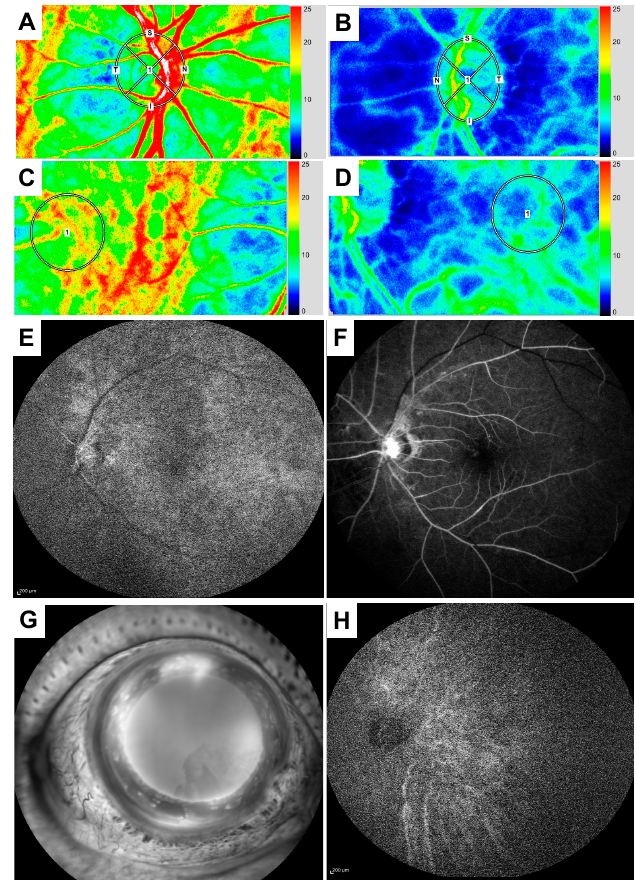
Figure 2. Laser speckle flowgraphy, fluorescein, and indocyanine green angiography findings from the baseline visit. Laser speckle flowgraphy (LSFG) findings in the optic nerve head (ONH) of the right ( A ) and left ( B ) eyes. LSFG findings in the macular of the right ( C ) and left ( D ) eyes. Fluorescein angiography (FA) findings in the left eye showed the prolonged times for the following: the choroidal flush was 20 s ( E ), the arm-to-retina was 26 s ( F ), and retinal circulation was 22 s. FA findings of the anterior segment in the left eye showed massive fluorescein leakage from the rubeosis iridis ( G ). ICGA findings also revealed the delay of the arm-to-choroid circulation time which was 19 s ( H ).